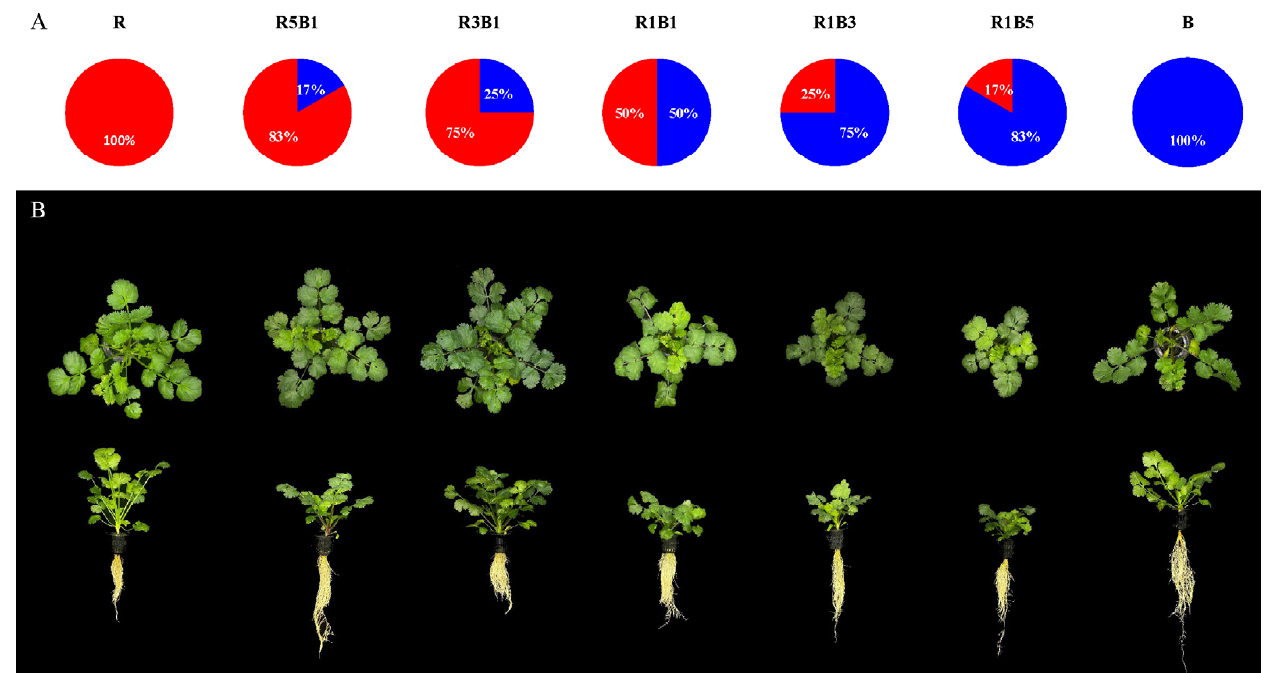
Figure 1. ( A ) Seven different R and B light ratio settings, respectively: R: monochrome red light treatment (200 μ mol m − 2 s − 1 ); R5B1: red–blue ratio of 5:1 (R: 167 μ mol m − 2 s − 1 and B: 33 μ mol m − 2 s − 1 ); R3B1: red–blue ratio 3:1 (R: 150 μ mol m − 2 s − 1 and B: 50 μ mol m − 2 s − 1 ); R1B1: red–blue ratio 1:1 (R:100 μ mol m − 2 s − 1 and B:100 μ mol m − 2 s − 1 ); R1B3: red–blue ratio 1:3 (R: 50 μ mol m − 2 s − 1 and B: 150 μ mol m − 2 s − 1 ); R1B5: red and blue light ratio of 1:5 (R: 33 μ mol m − 2 s − 1 and B: 167 μ mol m − 2 s − 1 ); B: Monochrome blue light treatment (B: 200 μ mol m − 2 s − 1 ), in which monochrome R and B light serve as